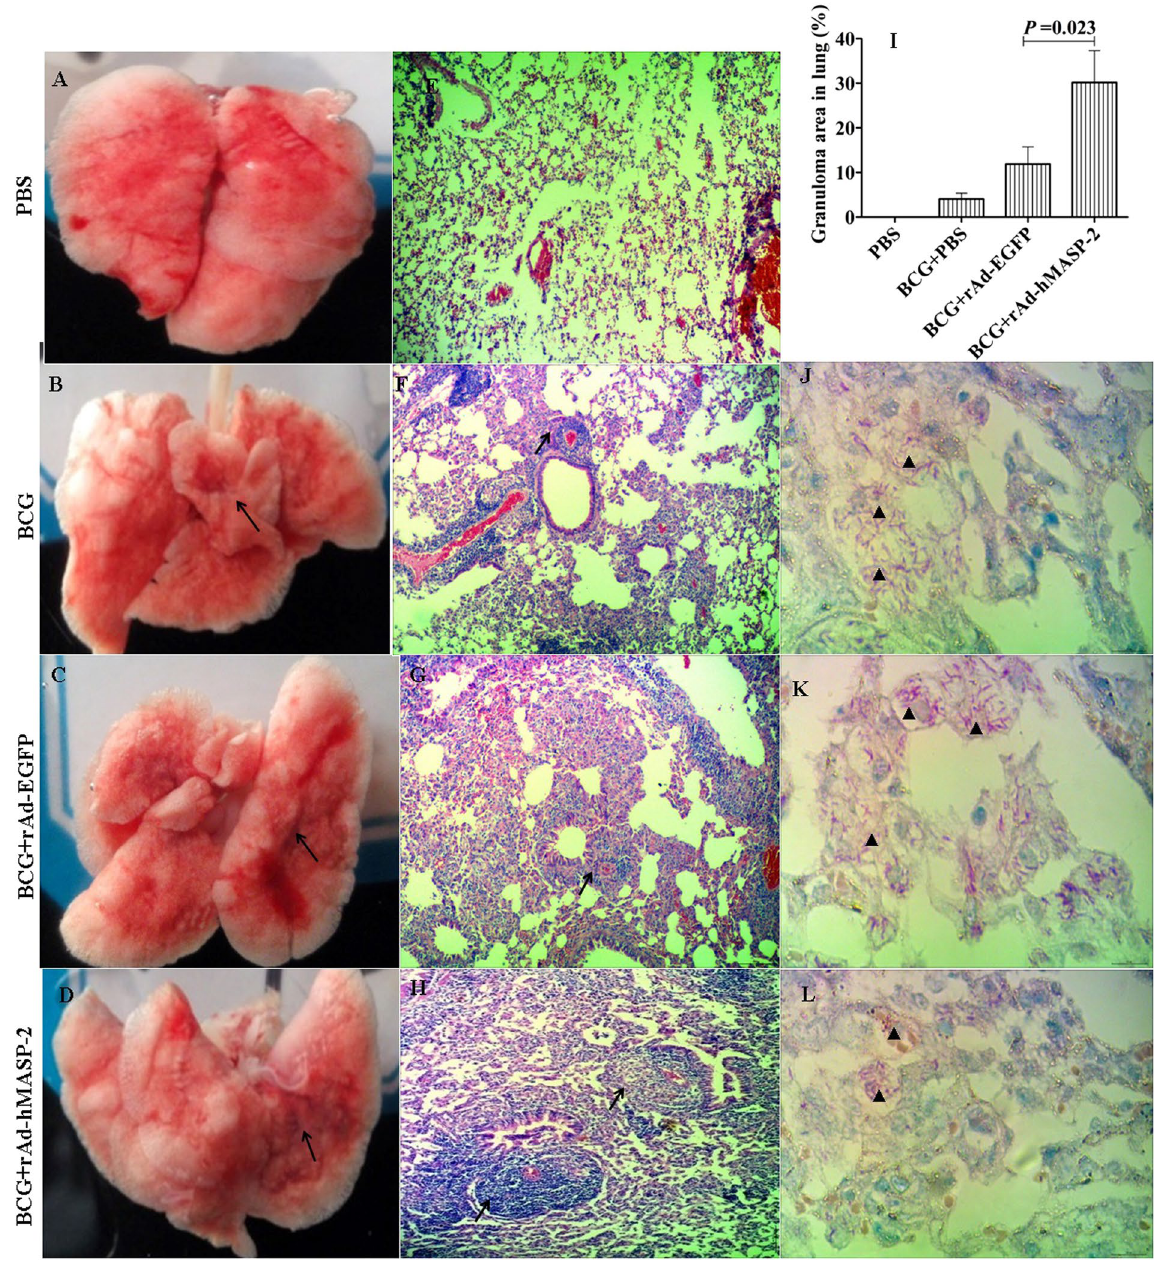
Figure 3. Comparison of the lung lesions in BALB/c mice. ( A ~ D ) Macroscopic images of the lungs at day 21 from 4 representative mice. ( E ~ H ) Histopathological analysis of hematoxylin-and-eosin (HE)-stained lung sections from 4 representative mice. Granulomatous lesions in BCG-infected mice ( B ~ D and F ~ E ) in contrast to normal lung tissue in PBS mice ( A and E ) at day 21 (arrows: granuloma lesions, × 200). ( J ~ L ) ZN-stained lung recuts showing bacilli ( ▲ ) growing ( J ~ L ) in BCG-infected mice and no bacilli within the uninfected mice. ( I ) Percentage of lung area involved in granulomatous lesions relative to total lung area used for morphometric analysis, n = 6 per group. Each point represents the mean of size of the lesions on each of six mice and its standard